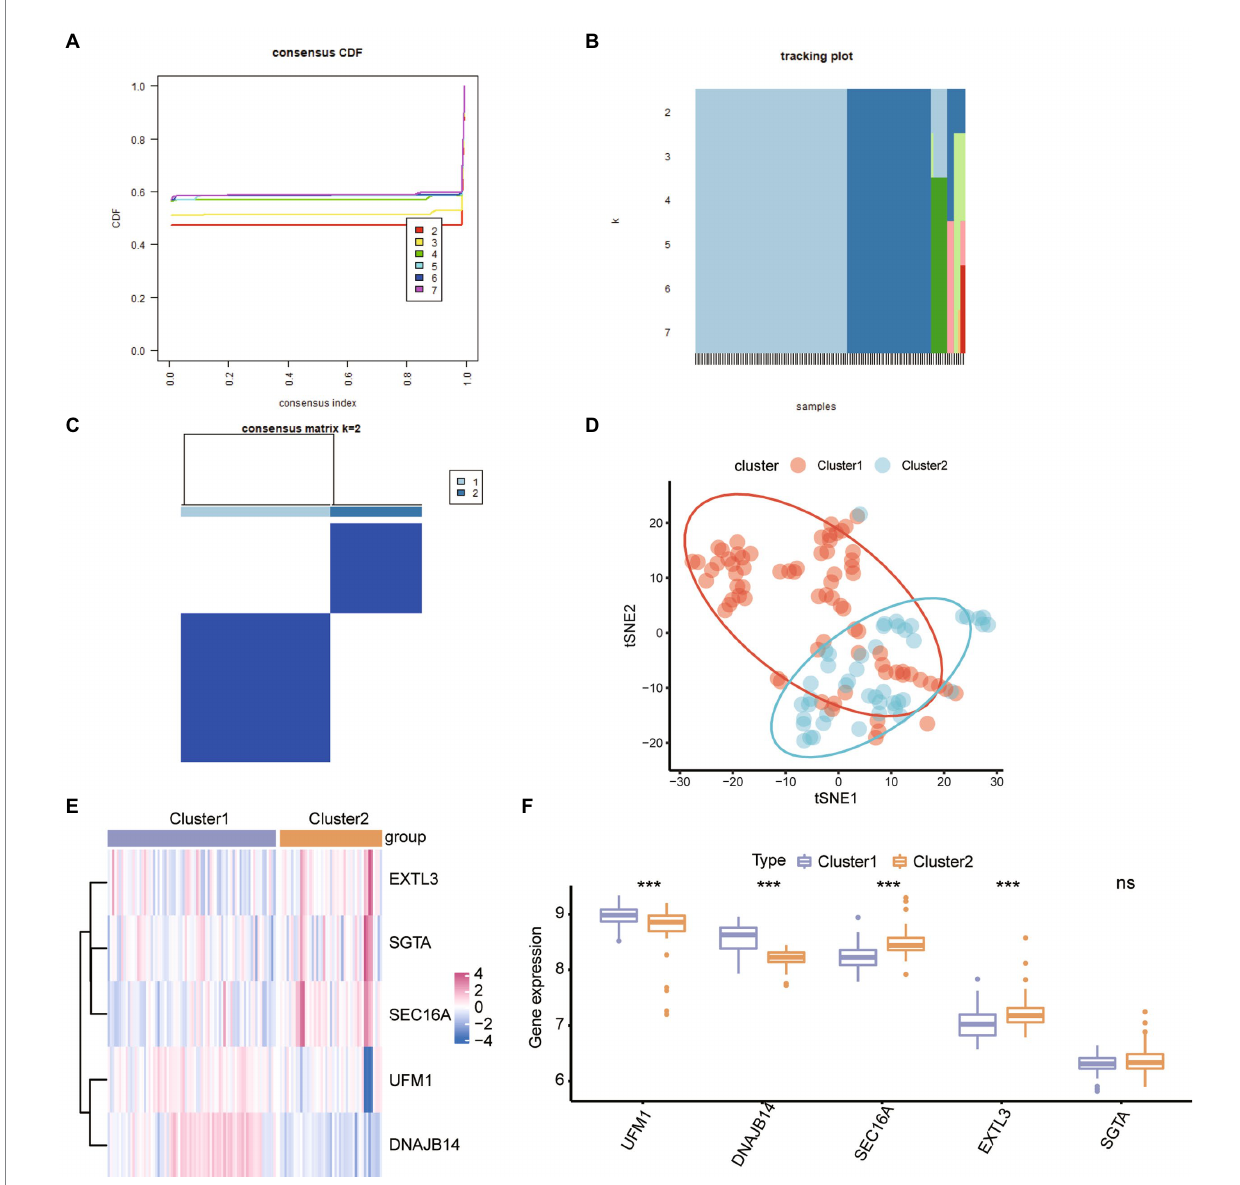
FIGURE 5 Identification of the ER stress patterns in ASD. (A) Consensus clustering cumulative distribution function (CDF) for k = 2–7. (B) The tracking plot shows the cluster assignment of items (columns) by color for each k (rows). (C) Heatmap describing co-occurrence proportions for ASD samples ( k = 2). (D) Tsne analysis for the transcriptome profiles of the ER stress patterns revealed a difference between ASD subclusters. (E,F) Heatmap and box plot of hub ER stress regulators’ expression in ASD subclusters. * p < 0.05, ** p < 0.01. *** < 0.001.